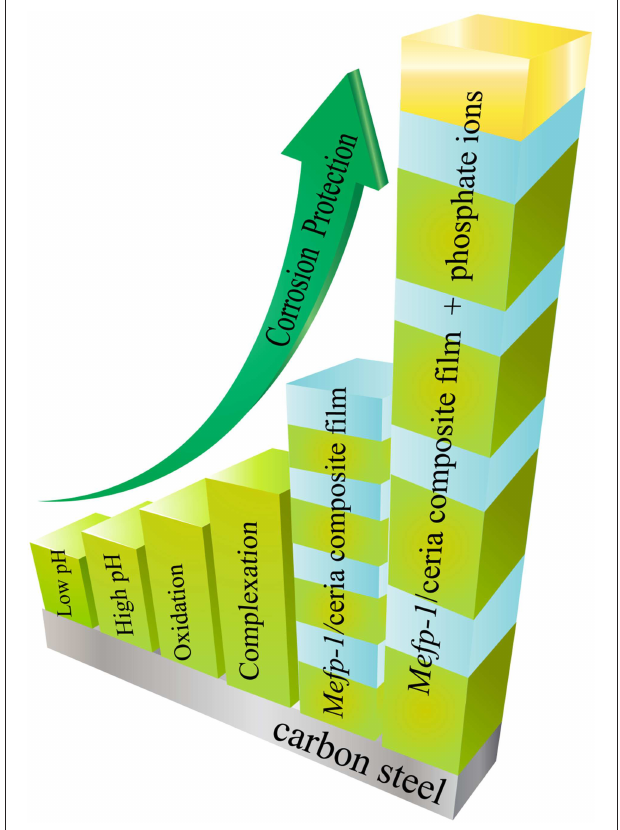
FIGURE 2 | Schematic illustration of the strategies that can be applied to enhance the corrosion inhibition properties of Mefp-1 .